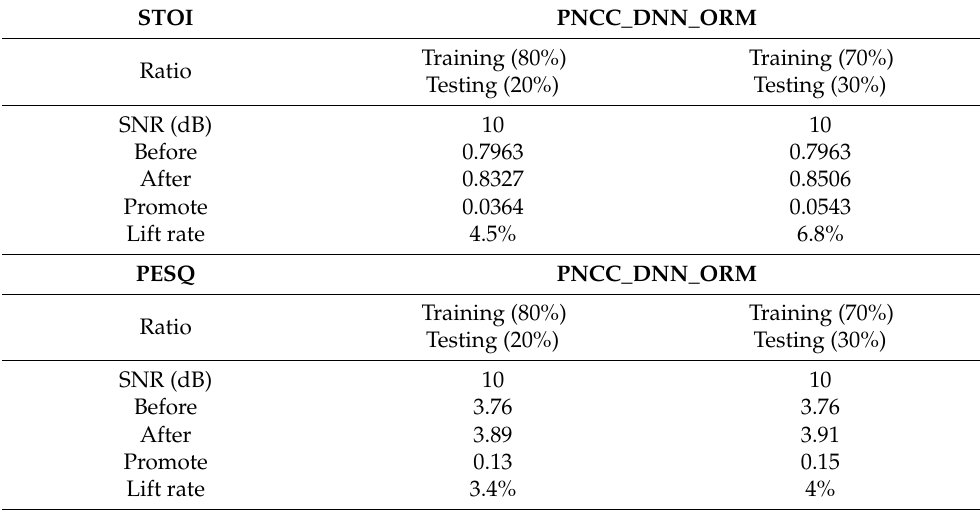
Table 8. Test data ratio selection.